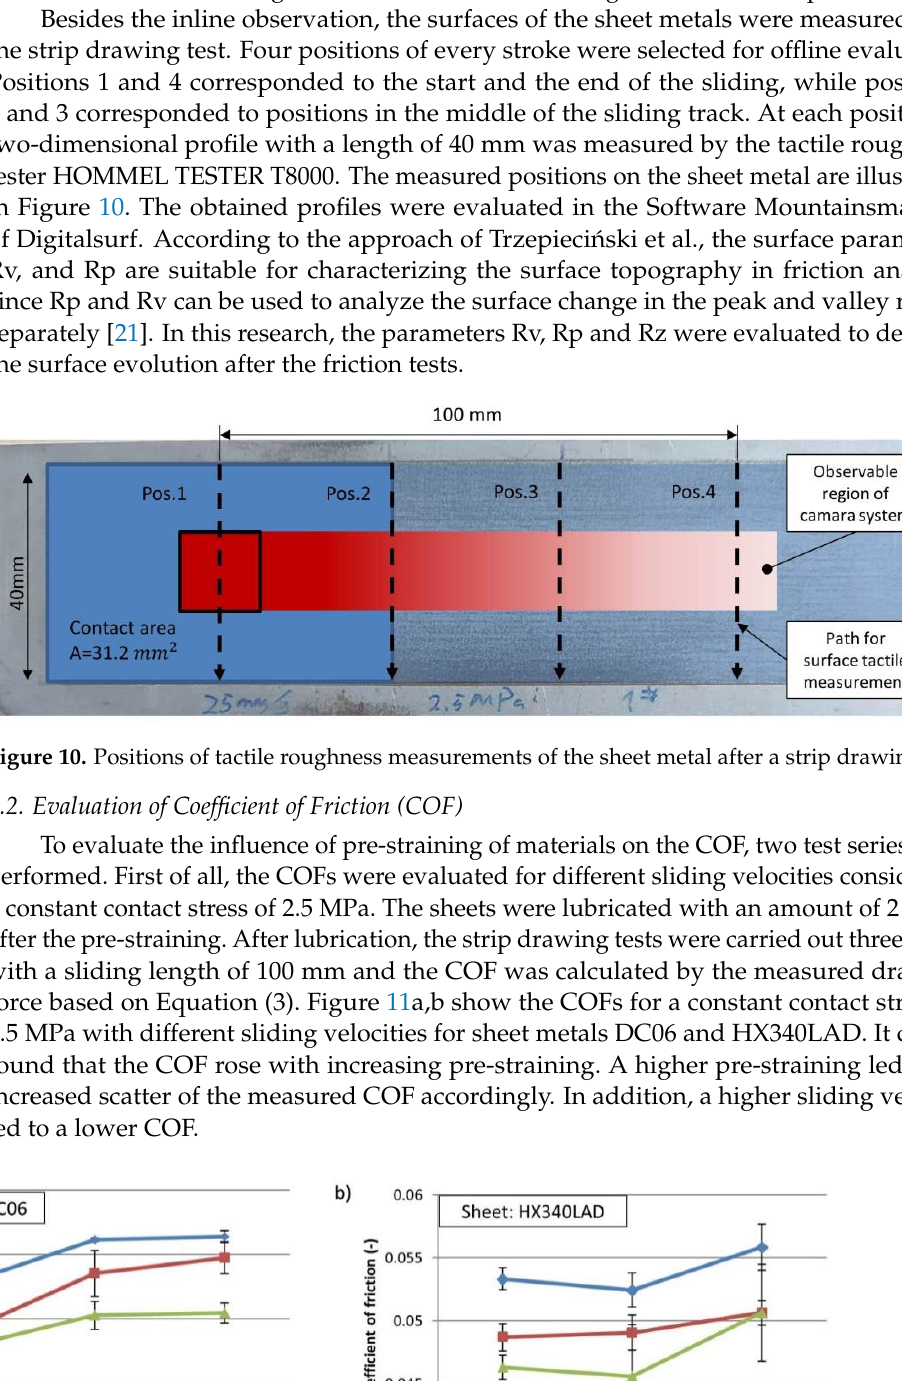
Figure 12. Coefficient of friction for different contact pressures and pre-straining considering a constant sliding velocity of 50 mm/s ( a ) Material DC06 with electrolyte galvanized coating ( b ) Material HX340LAD with galvanized coating. Based on these results, it can be concluded that an increased pre-straining of the sheet metal resulted in an increased COF. The question therefore is, whether the surface change resulting from pre-straining was the main factor causing the COF increase. In the following sections, the surface changes of the test sheets were analyzed by roughness measurements and surface observations to interpret the measured COF evolutions. 3.3. Evaluation of the Measured Surface Roughness For the analysis of surface roughness, the roughness parameters Rz, Rp and Rv of the drawn sheet metal were evaluated after the drawing tests. According to DIN EN ISO 4287, Rp describes the peak height of the asperities, while Rv represents the maximum valley depth. The sum of Rp and Rv is equal to Rz [32]. With the help of these three pa- rameters, it is possible to evaluate the surface change of the peak (Rp) and the valley (Rv) separately as well as their influence on the peak to valley height Rz. First, 2d profiles with a length of 40 mm were measured on four positions of the sheet metal surface and the average value of the surface roughness was calculated to describe the surface change during each stroke of the test. Since every test was repeated three times, an additional average value of the roughness of the three strokes was calcu- lated to describe the surface change of every test. Together with the initial surface roughness after the pre-straining, the surface roughness Rz, Rp and Rv of the sheet met-